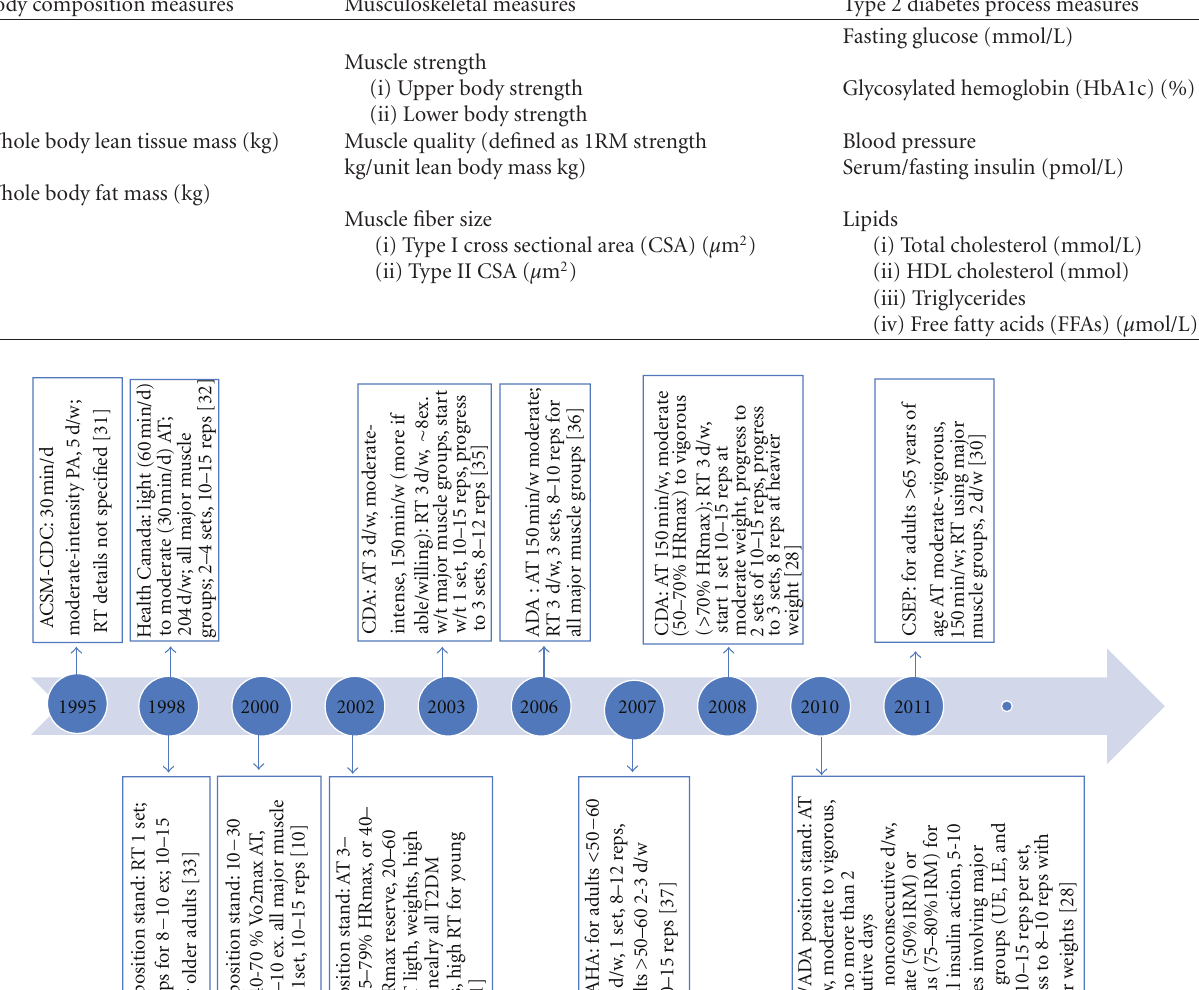
Table 1: Outcome measures.